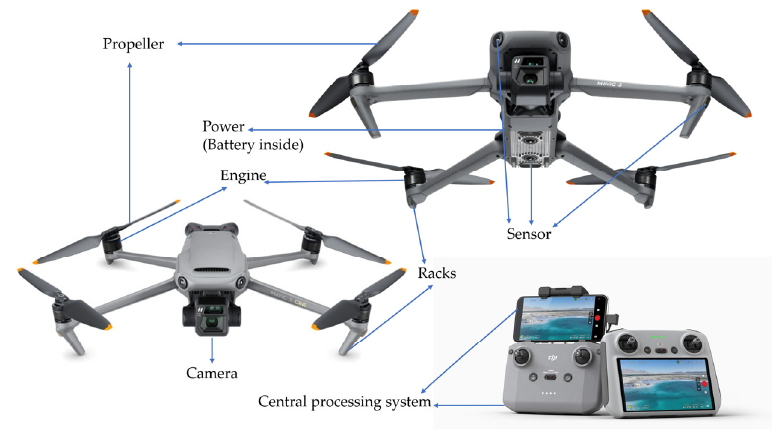
Figure 1. Structure of Drones.